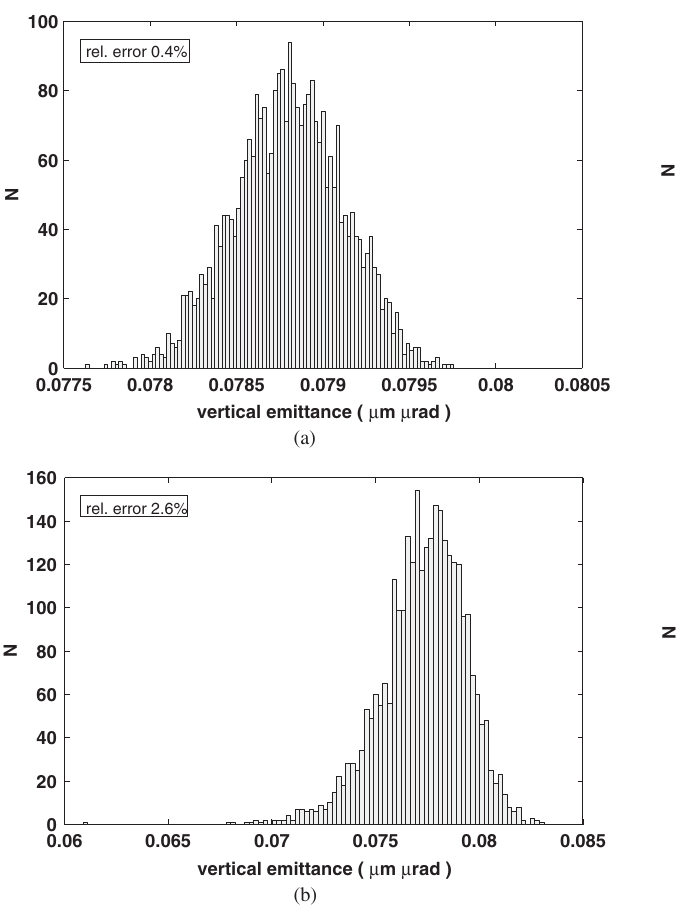
FIG. 18. Distribution of reconstructed vertical emittance with 1% (a) and 5% (b) random errors on the beam size measurement for a 4D diagnostics section assuming 50% random mismatch of initial optical functions (statistics corresponding to train